Question: Sum up the contents of this chart in one sentence.
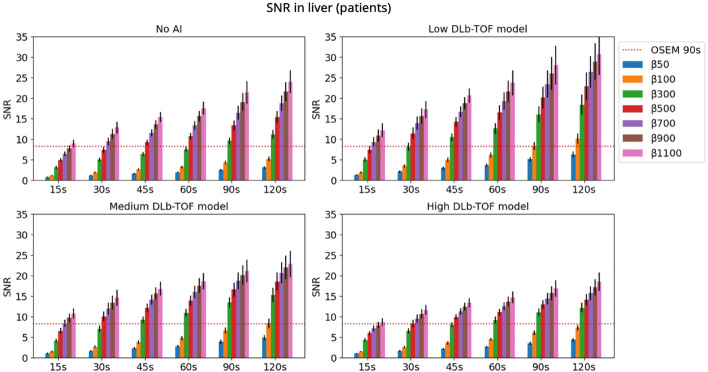
Answer: Signal-to-noise (SNR), according to Eq. ( 1 ), in lesion-free liver as a function of acquisition time and β-value without (No AI) and with the three levels of DLb-TOF model (Low, Medium and High). The dotted line represents SNR for 90 s acquisition time reconstructed with OSEM. Error bars indicate ± 1 SD